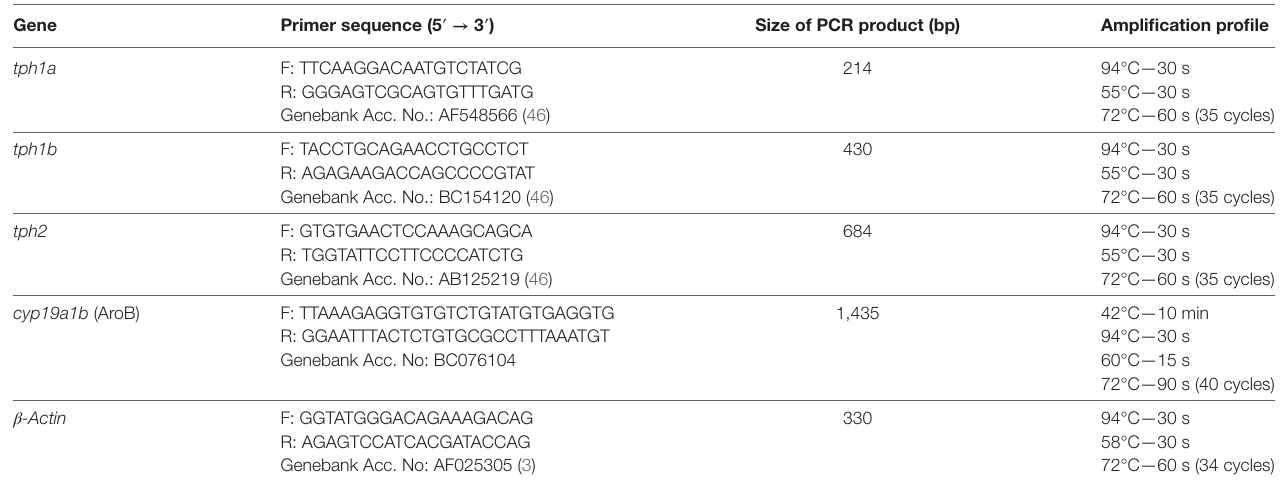
TaBle 2 | PCR primers and